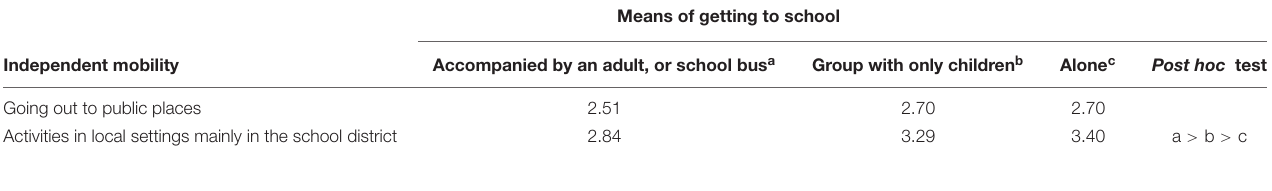
TABLE 8 | Associations of means of getting to school with independent